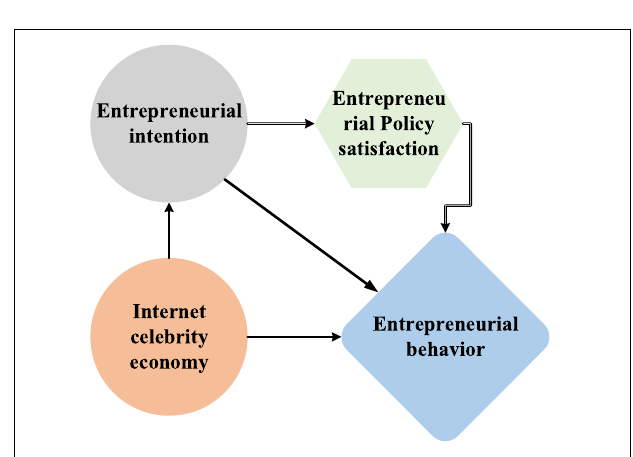
FIGURE 5 | The influence relationship among the four variables of the Internet celebrity economy, entrepreneurial intention, entrepreneurial policy satisfaction and entrepreneurial